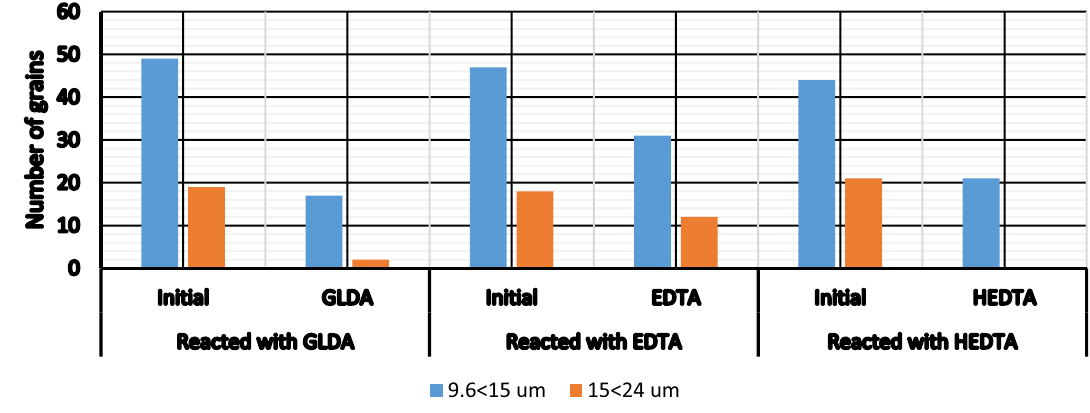
Fig. 13 The grain size distribution of Calcite in Berea Sandstone before and after reaction with chelating agents